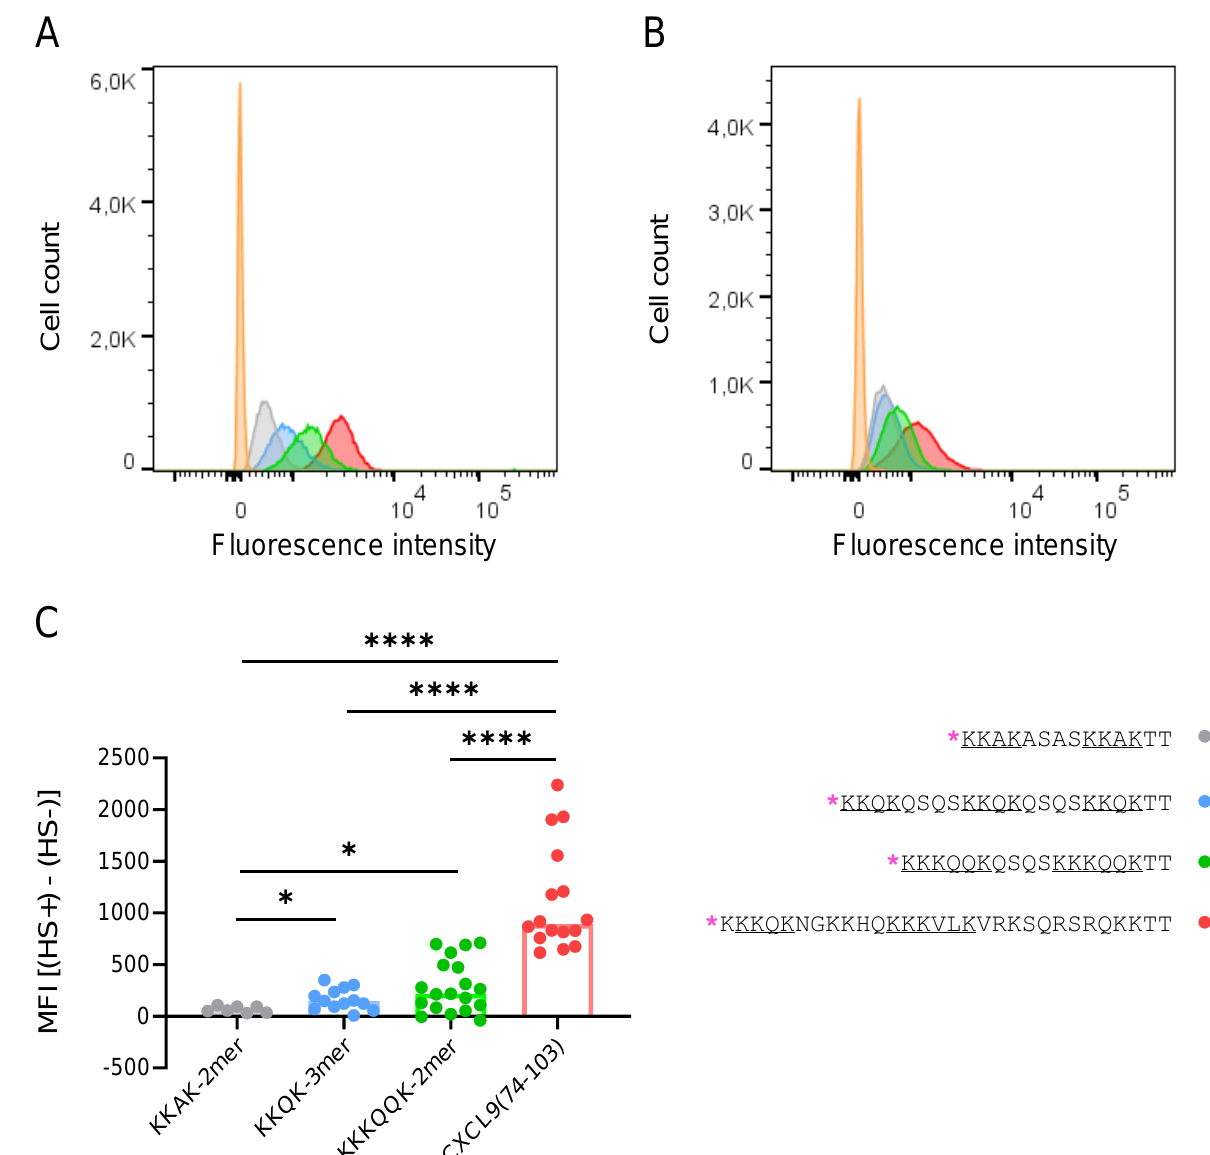
Figure 7. Peptides show differential binding capacity for cellular GAGs on CHO cells. TAMRA- labeled peptide (0.24 nmol; KKAK-2mer (gray), KKQK-3mer (blue), KKKQQK-2mer (green), CXCL9(74-103) (red), unstained (orange)) was added to either HS + or HS − CHO cells and binding was assessed using flow cytometry. ( A , B ) Histograms (of one representative experiment) of the HS + ( A ) and HS − ( B ) CHO cells are shown with the cell count on the y-axis and the fluorescence intensity of the TAMRA-labeled peptides on the x-axis. ( C ) Median fluorescence intensity (MFI) values were normalized first by subtracting the MFI of the unstained sample (background). The difference between the MFI of the HS + and the HS − CHO cells is displayed (y-axis) for each peptide (x-axis). ( n ≥ 7; Mann–Whitney test, * p < 0.05, **** p < 0.0001 (comparison of the different peptides)). The amino acid sequences of the peptides are depicted on the right with TAMRA indicated in pink [*] and the GAG-binding motifs underlined.